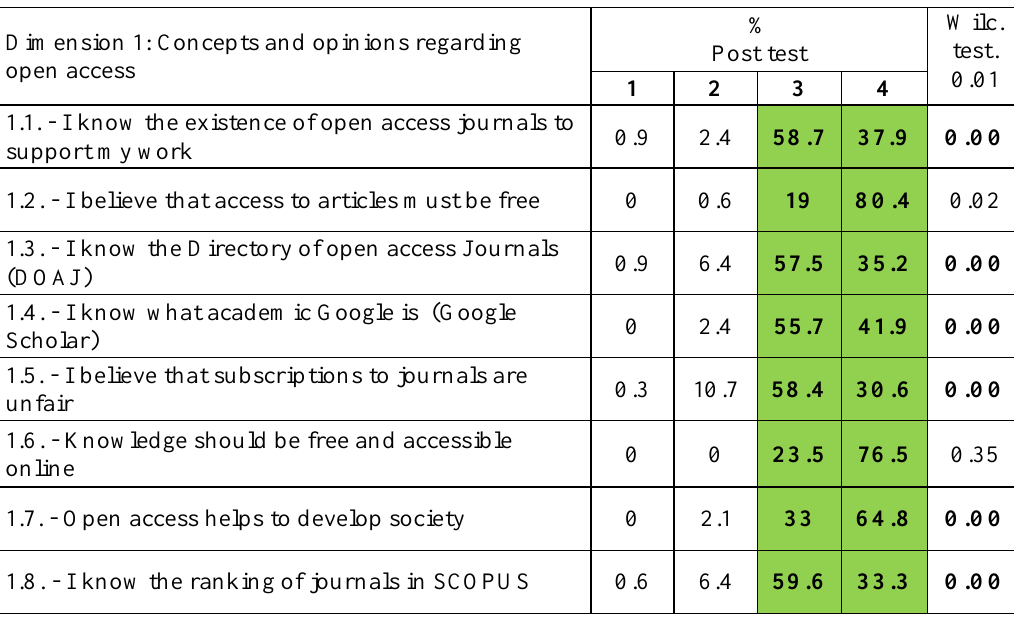
Table 2 Dimension 1: Concepts and Opinions Regarding Open Access. Post-Test Frequencies and Wilcoxon Test Dimension 1: Concepts and opinions